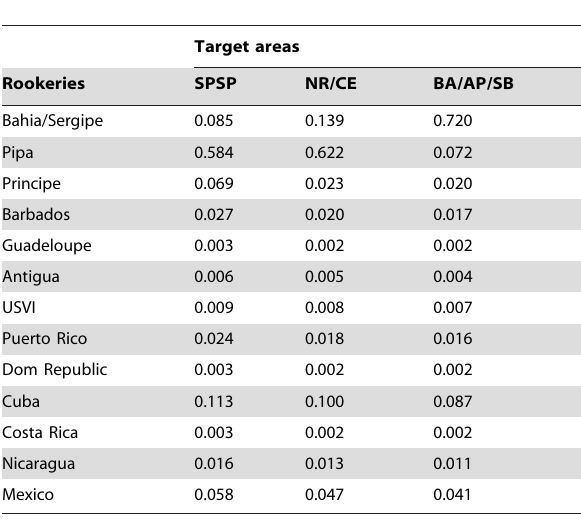
Table 4. Natal origins for E. imbricata in Brazilian waters as estimated by